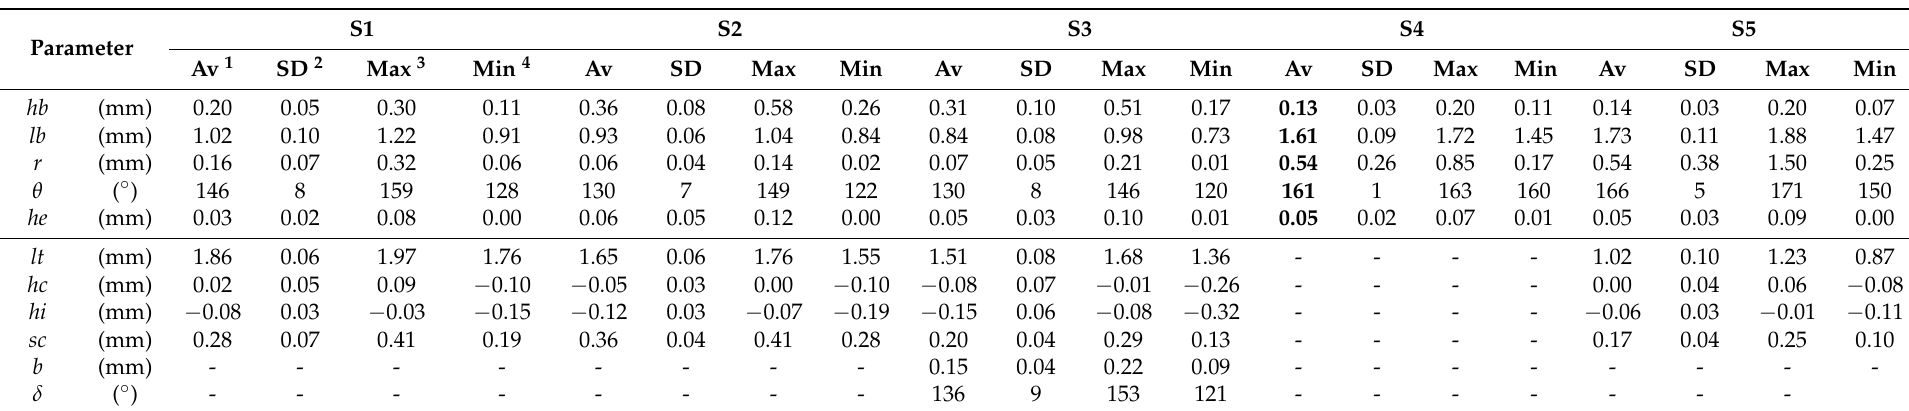
Table 4. Geometrical parameters of the welded